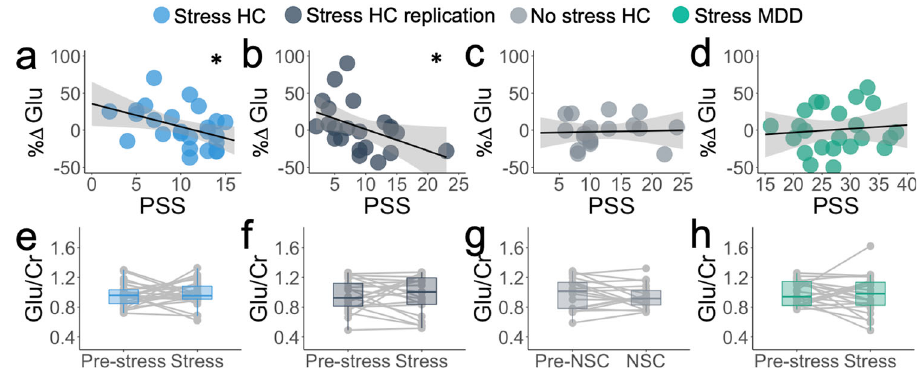
Fig. 2 Changes in mPFC creatine-normalized glutamate in response to acute and perceived stress. a Association between perceived stress (PSS scores) and percent change in Glu/Cr signal ( r s(23) = − 0.457, p = 0.022, two-tailed, uncorrected) in healthy control stress sample. b Association between perceived stress (PSS scores) and percent change in Glu/Cr signal ( r s(20) = − 0.517, p = 0.014, two-tailed, uncorrected) in the healthy control stress replication sample. c Association between perceived stress (PSS scores) and percent change in Glu/Cr signal ( r s(16) = 0.139, p = 0.581, two-tailed, uncorrected) in no-stress control sample. d Association between perceived stress (PSS scores) and percent change in Glu/Cr signal ( r s(21) = 0.115, p = 0.602, two-tailed, uncorrected) in participants with major depressive disorder. Shaded area on a – d represents 95% con fi dence interval, * p < 0.05.